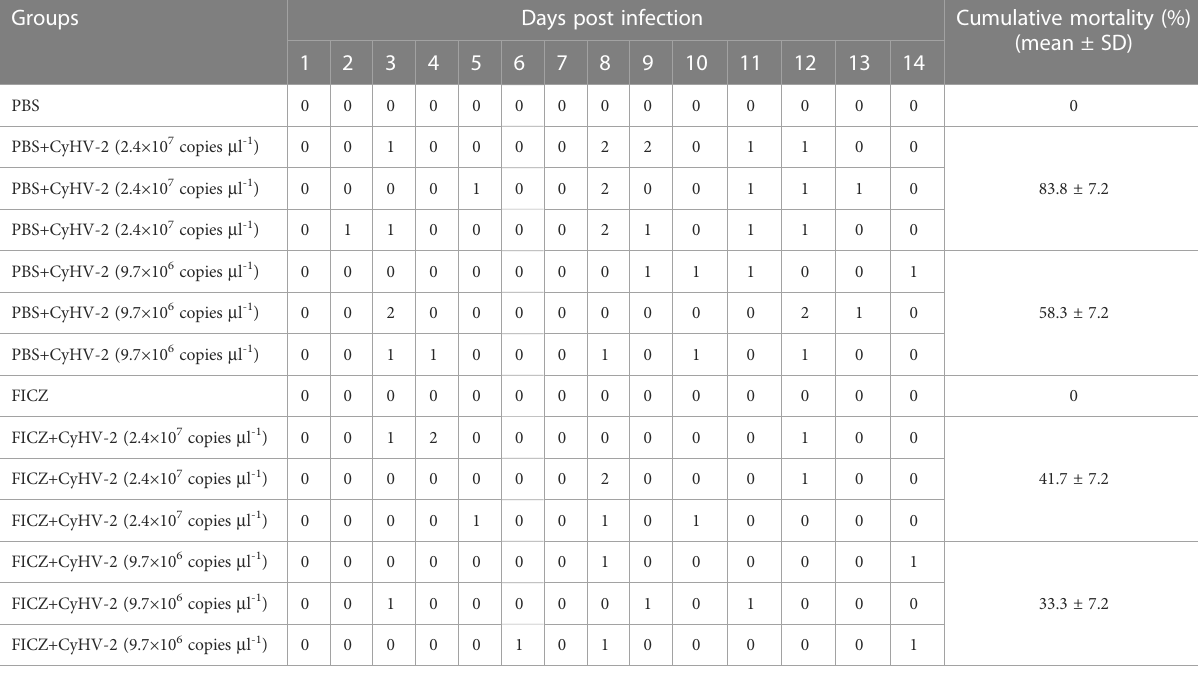
TABLE 3 Effect of aryl hydrocarbon receptor (AhR) expression on the cumulative mortality of fi sh post-CyHV-2 infection. Groups Days post